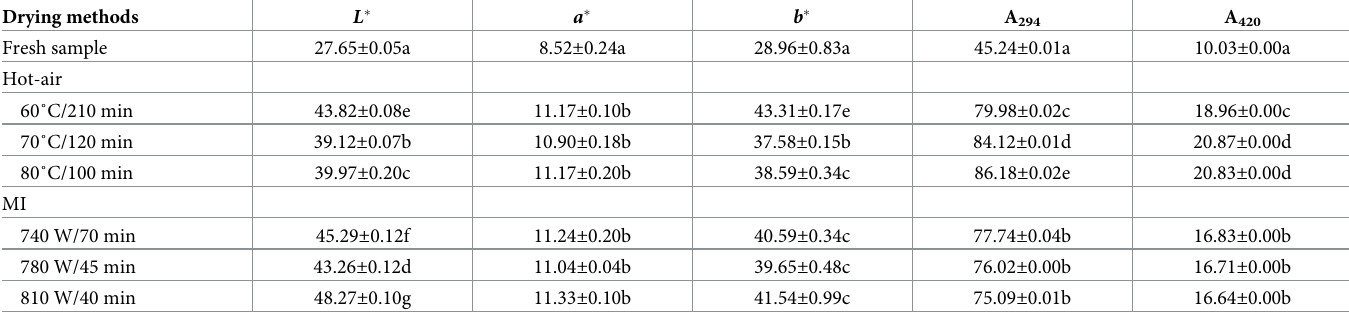
Table 2. Color ( L � , a � and b � values) and browning index (A 294 and A 420 ) of Tai-Pla curry paste (fresh sample) and Tai-Pla curry powder dried using hot air (HA) and hybrid microwave-infrared drying (MI) under different drying conditions. Drying